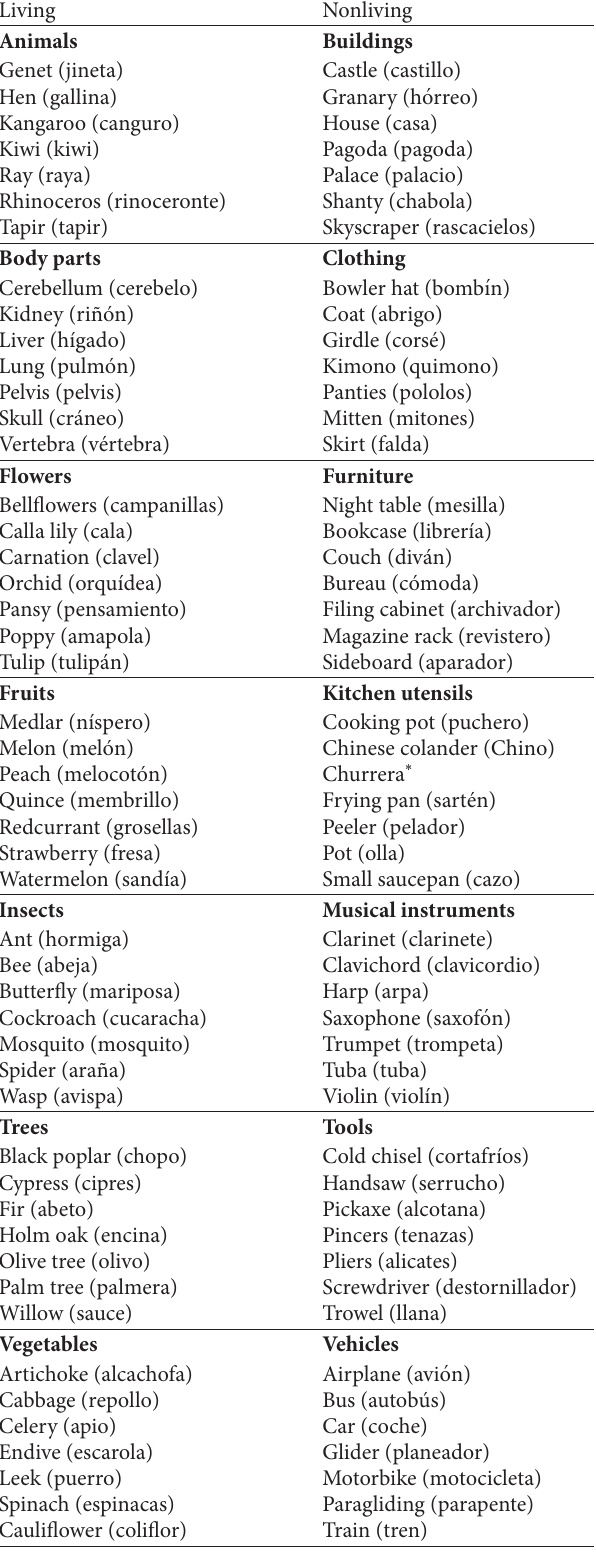
Churrera: non-English translation: tool used for making churros (fried